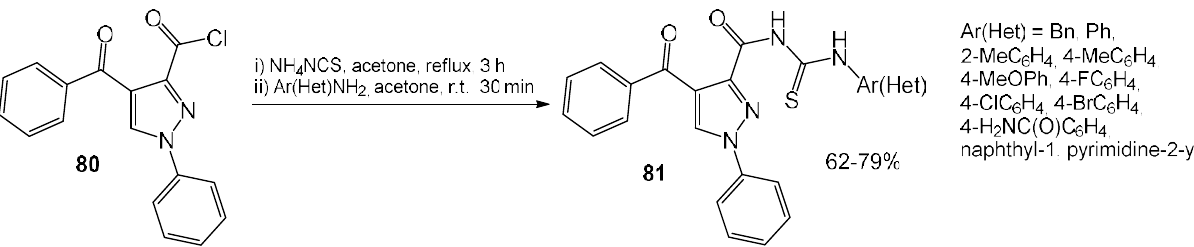
Fig. 22. Approaches to the synthesis of N -[(4-( N -(pyrimidin-2-yl)sulfamoyl)phenyl)carbamothioyl]acylamides